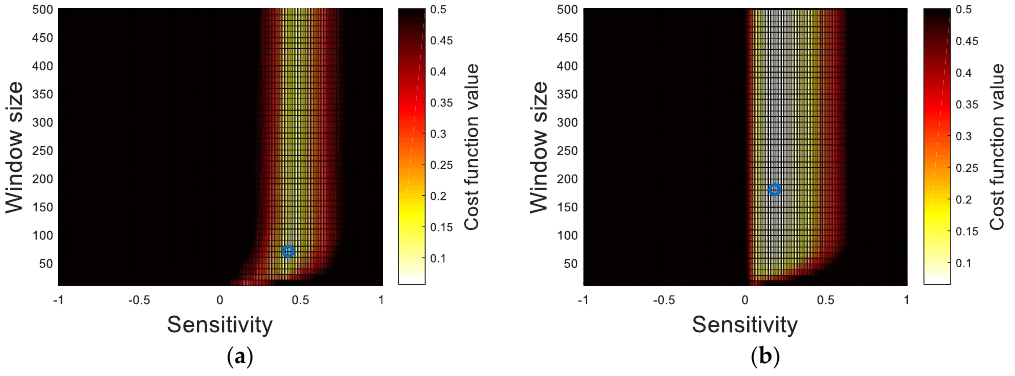
Figure 8. Cost functions in terms of window size and sensitivity: ( a ) J w ; and ( b ) J l . Table 2. Optimal crack width and length parameters.